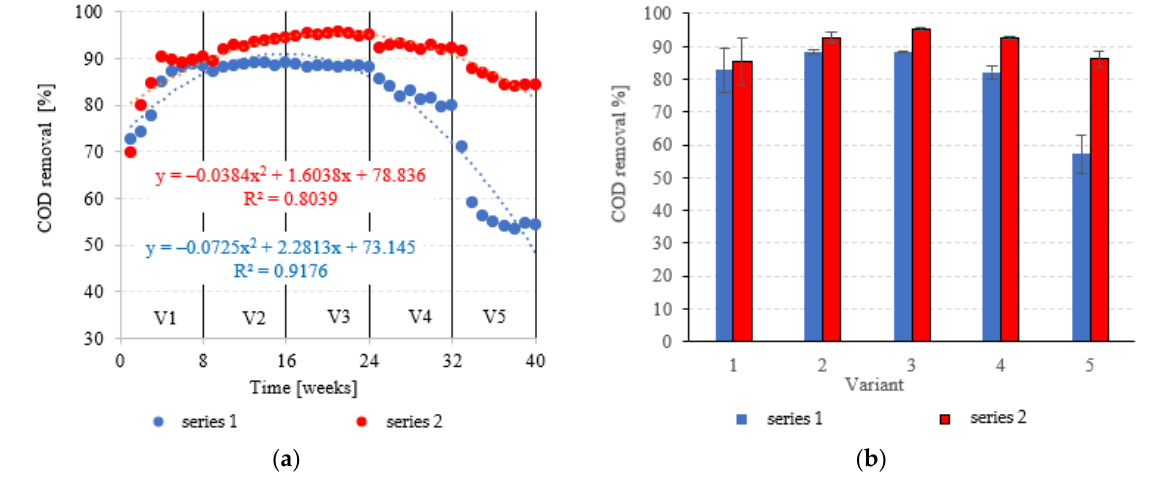
Figure 6. COD removal (( a ) changes throughout the experiment; ( b ) average across experimental variants).